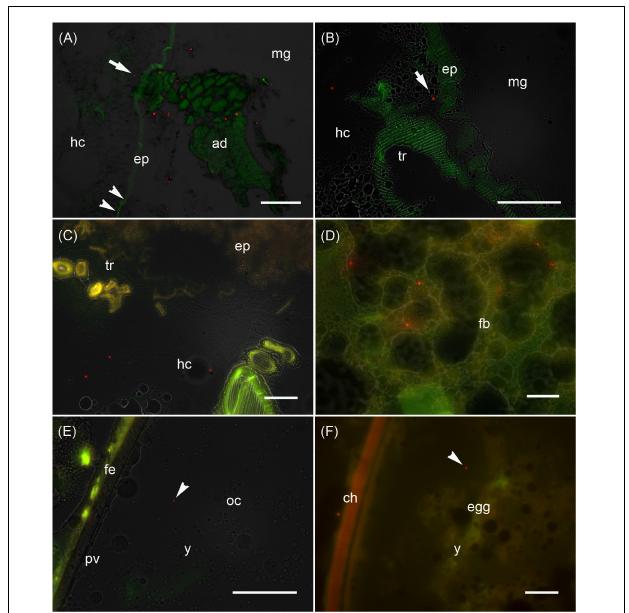
FIGURE 3 | Analysis of the maternal transfer of bacteria in M. sexta by fluorescence microscopy Cryosection of third-instar larva (A–D) , adult ovary (E) and oviposited egg (F) . (A) Cross-sections of midgut region (md) after the uptake of artificial diet (ad) supplemented with E. coli Bioparticles labeled with Texas Red (red spots). Translocated Bioparticles are also detectable in the midgut epithelium (ep, arrowheads) and in the hemocoel (hc, arrow). Scale bar = 100 µ m. (B) Magnification of the midgut region with adjacent tracheole (tr) shows Bioparticles immediately beneath the midgut epithelium (arrow). Scale bar = 100 µ m. (C) Cross-sections of the midgut region reveal numerous Bioparticles distributed in the hemocoel. Scale bar = 50 µ m. (D) Fluorescent bacteria are also abundant in the fat body tissue (fb). Scale bar = 50 µ m. (E) Female reproductive system dissected from adults reared on artificial diet containing Bioparticles during earlier larval stages. Fluorescent bacteria (arrowhead) are located in the yolk mass (y) of a developing oocyte (oc) which is surrounded by a thin perivitelline membrane (pv) and the follicle epithelium (fe). Scale bar = 100 µ m. (F) Ovipositioned egg (egg) with an enclosing chorion (ch) contains bacterial probes (arrowhead) in the yolk mass (y). Scale bar = 50 µ